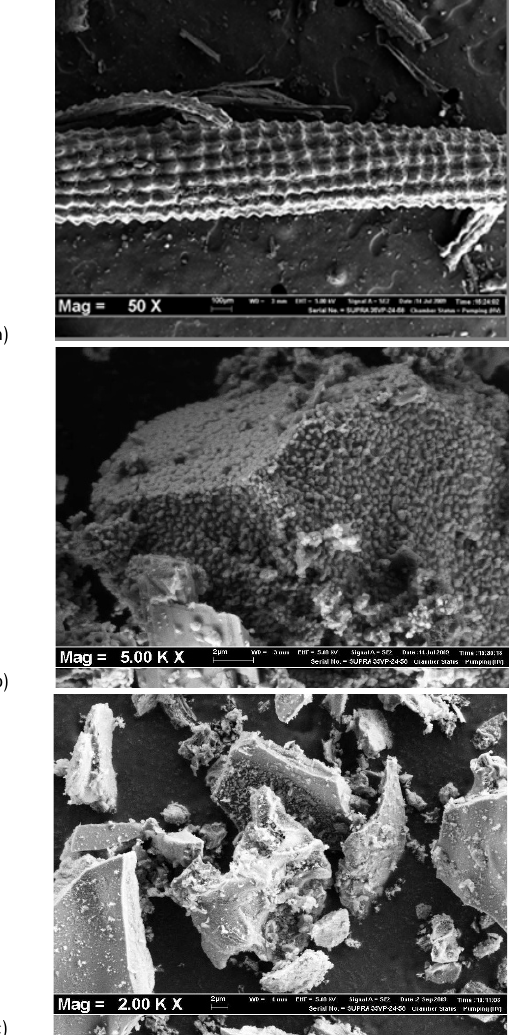
Figure 3. SEM images of the materials: a) OPC; b) RHA-unground; c)